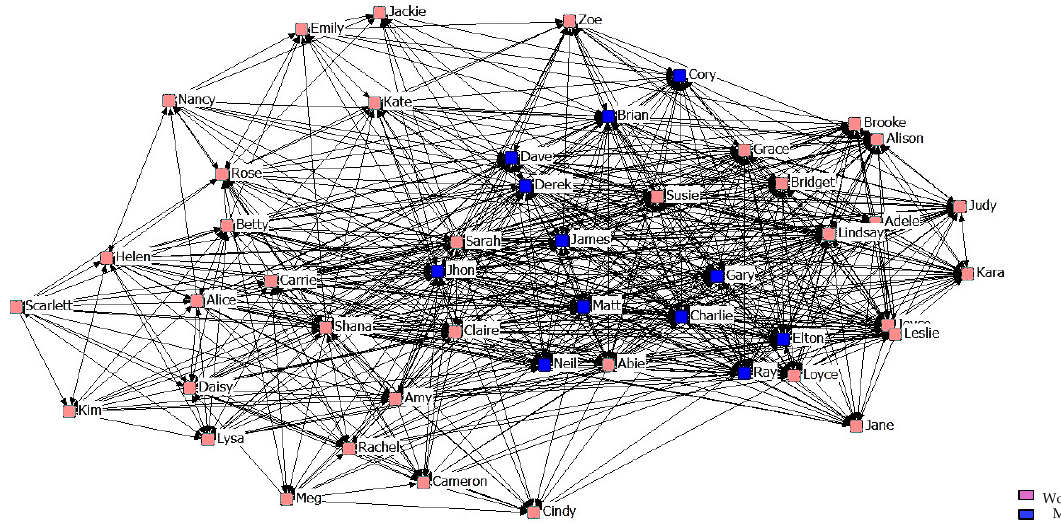
Figure 4. Graph of the first year Minimum Friendship Network.